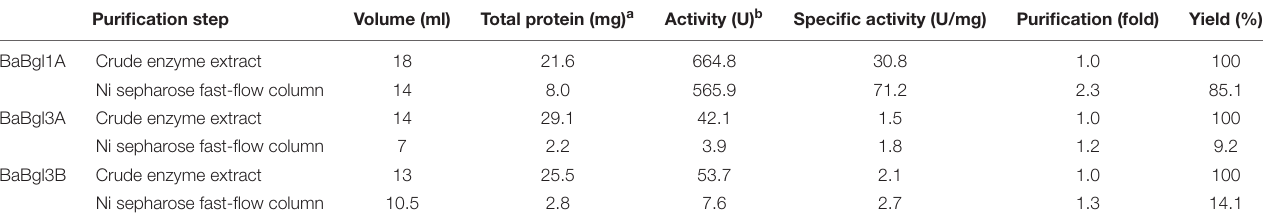
TABLE 2 | Summary of the purification of recombinant three β -glucosidases from Bifidobacterium adolescentis